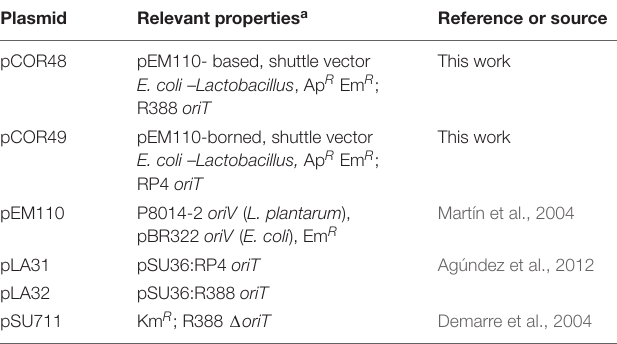
TABLE 2 | Plasmids used in the present study.